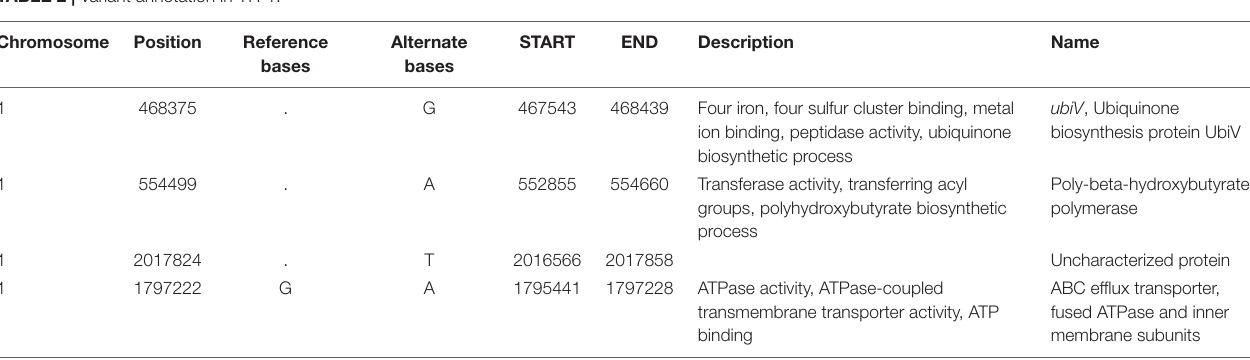
FIGURE 3 | Isolation of YR-1 mutant. (A) Serial transfer of the NTG mutant library. Experiments were subcultured three times and cultivated under 10% of CO 2 and 60% of H 2 . (B) Screening of mutant for isolation of YR-1. The candidates were randomly selected and growth was estimated under 10% of CO 2 and 60% of H 2 . Experiments were conducted in triplicate and error bars indicate standard deviation of mean. TABLE 2 | Variant annotation in